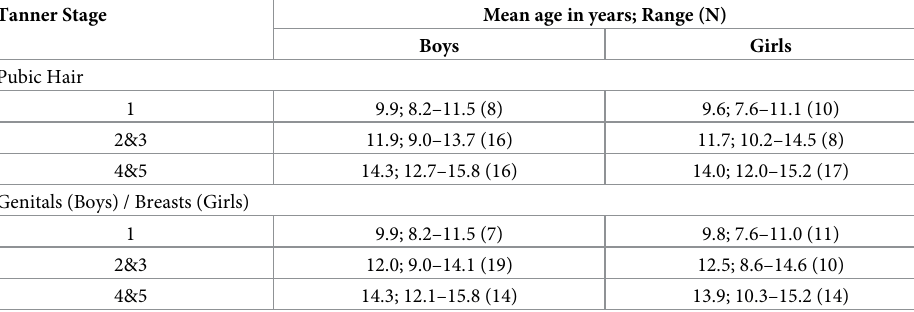
Table 2. Mean age by child self-reported Tanner stage at third (final)